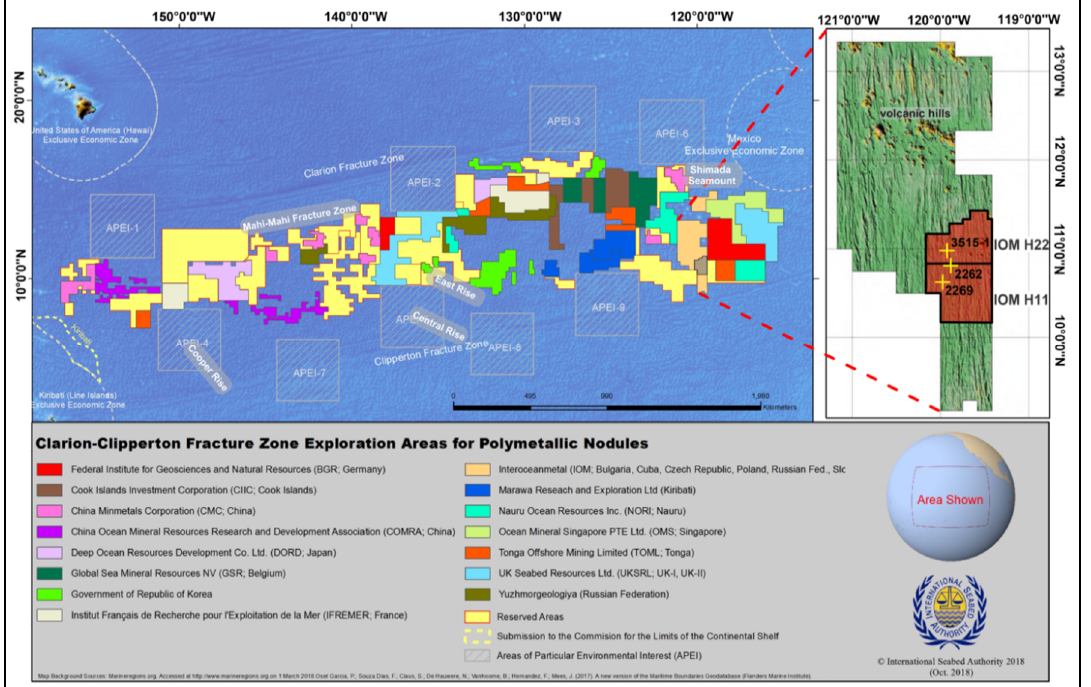
Figure 1. Location of the sampling area within the Clarion−Clipperton Fracture Zone (CCFZ). Individual contractors are shown with different colours (map adapted from [31]). On the right, the geomorphological map of Interoceanmetal (IOM) H11 and H22 polymetallic nodules polygons [32]. Yellow crosses indicate sediment sampling stations 2262, 2269, and 3515-1. The general topography of the seafloor reveals meridian-like streaked patchy zonation. In the northern part, several NW–SE-oriented volcanic hills are distinctive in the seafloor morphology.